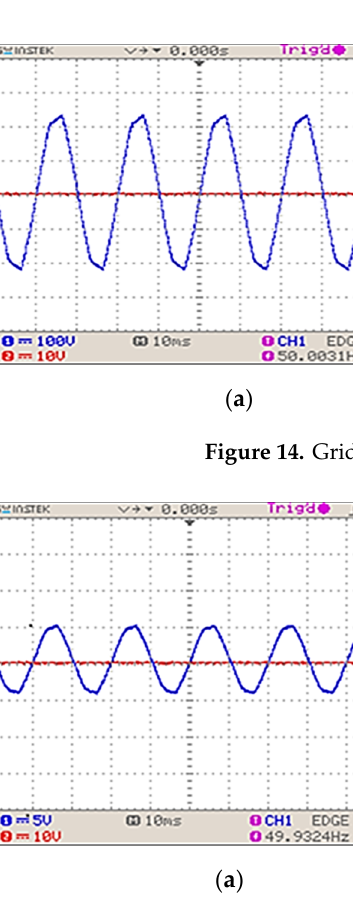
Figure 17. Grid current total harmonic distortion (THD).